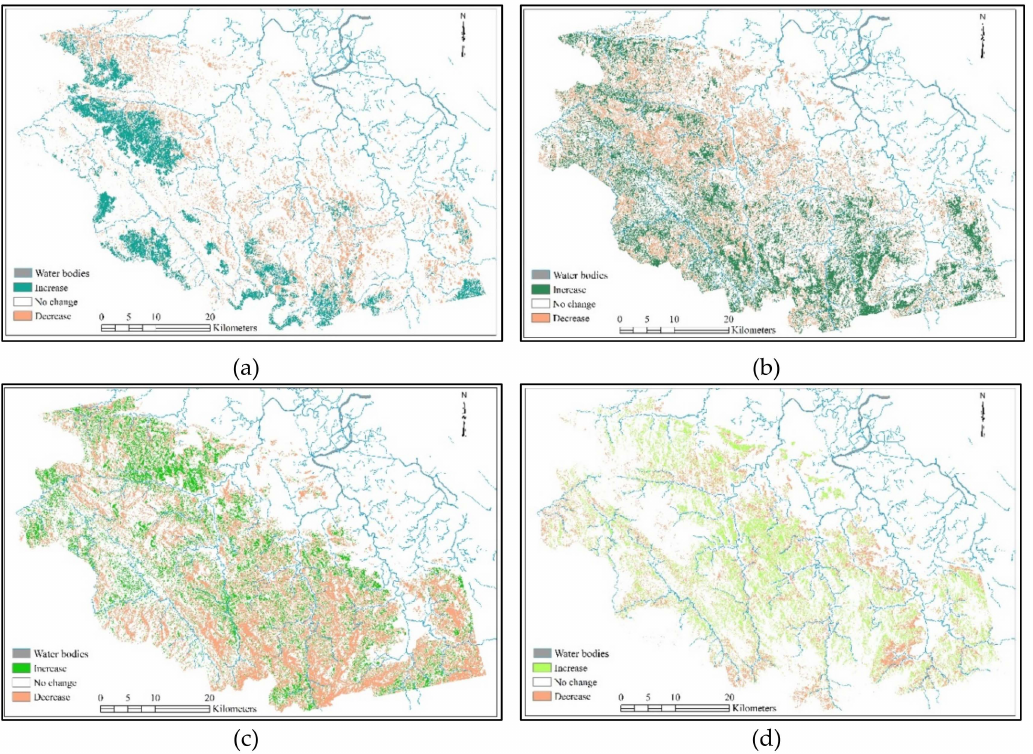
Figure 6. Changes in ( a ) rich forest, ( b ) medium forest, ( c ) poor forest, and ( d ) restoration forest between 2007 and